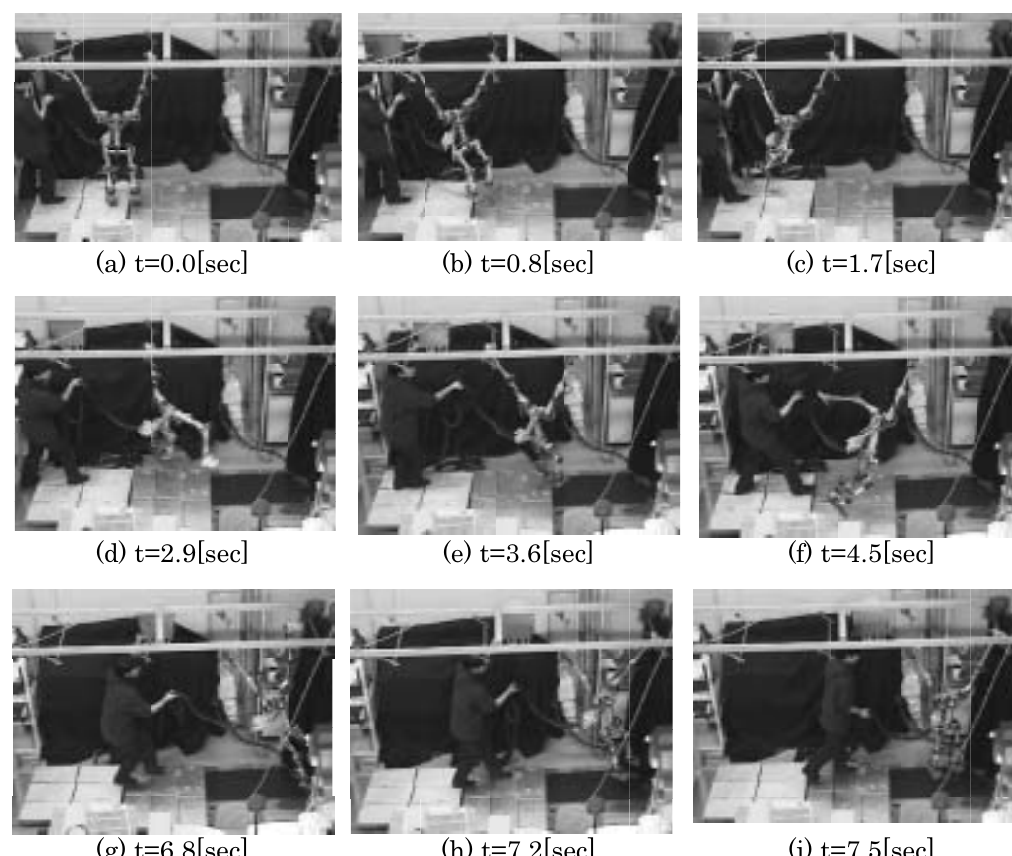
Figure 21 Stroboscopic photography of continuous